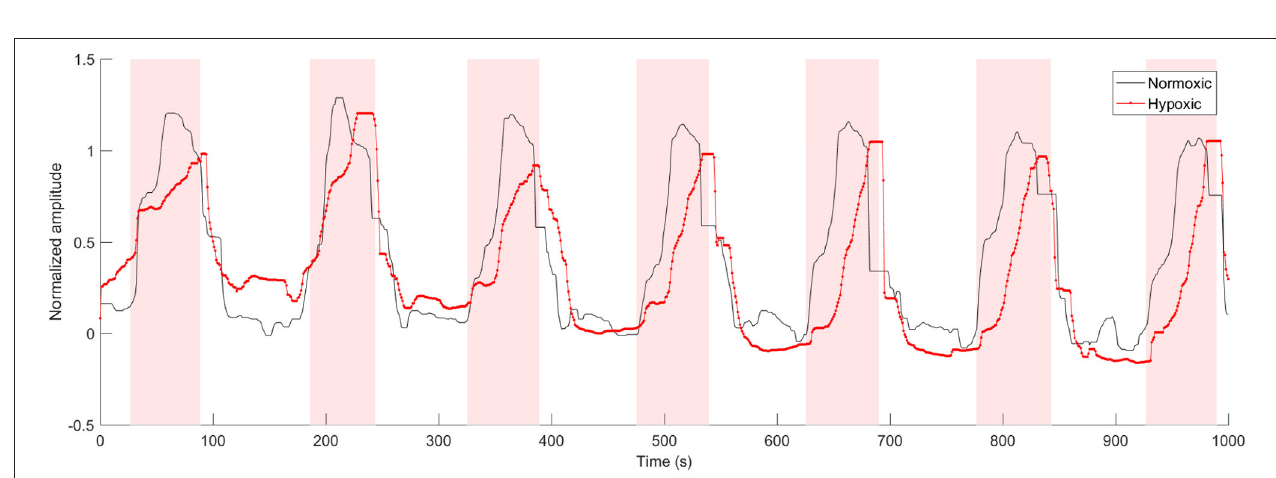
FIGURE 2 | Scatter plot for each pair of the morphological parameters, i.e. , (A) τ u vs. τ r , (B) τ u vs. a , (C) τ r vs. a , (D) b vs. τ u , (E) b vs. τ r and (F) b vs. a , for both normoxic (black triangle) and hypoxic fetuses (red circle). Contour plots are also reported (prepared with an assumption of Gaussianity, made for visualization